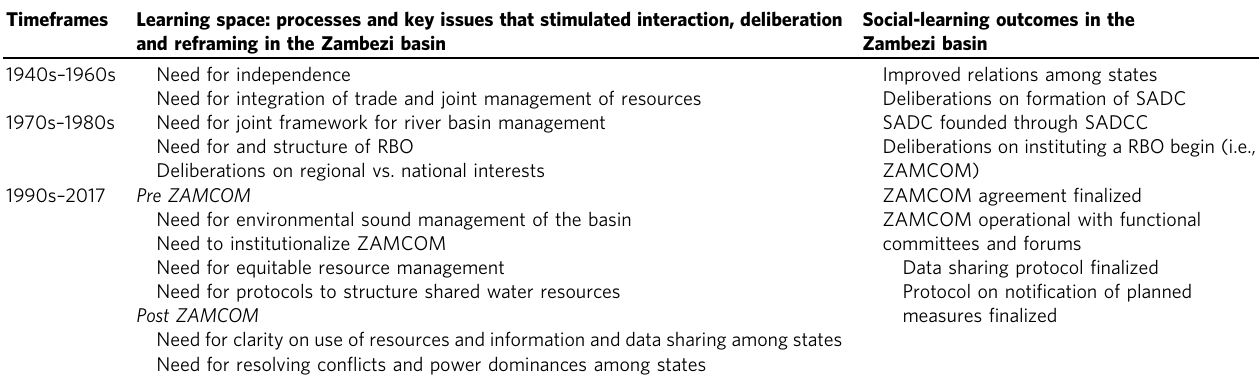
Table 3 Learning space and social-learning outcomes in the Zambezi basin over time.